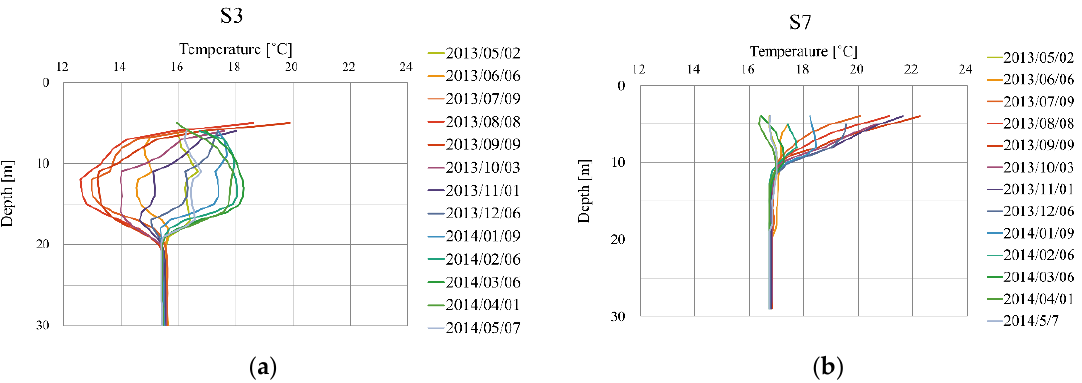
Figure 3. Vertical profiles of groundwater temperature of the observation wells in the alluvial fan of the Nagara River. Wells S3 ( a ) and S7 ( b ) are in the middle and toe of the alluvial fan, respectively.